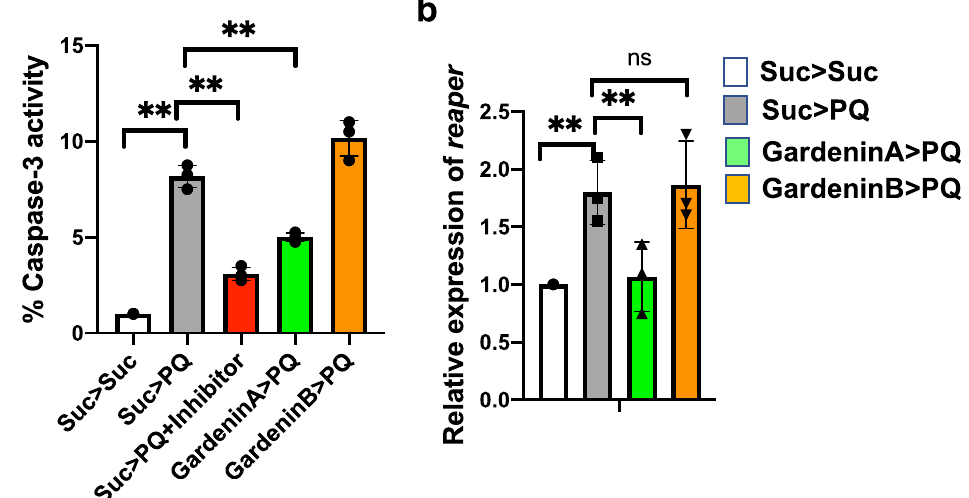
Fig. 5 Effects of GardeninA and GardeninB on the caspase dependent apoptotic responses in Drosophila . a Caspase-3 activity was measured in response to GA and GB using fl uorometric assay. Adult male fl ies were either pre-fed for 4 days with 2.5% sucrose or GA or GB (10 μ M) followed by exposure to either sucrose or 5 mM PQ or PQ + caspase-3 inhibitor (Ac-DEVD-CHO) for 24 h (white bar: Suc>Suc, gray bar: Suc>PQ, red bar: Suc>PQ + inhibitor, green bar: GardeninA>PQ, orange bar: GardeninB>PQ). The fl y head homogenates were used to detect the caspase-3 activities. Data are expressed as percentage in relation to the Suc>Suc control and represent averages from at least three independent biological repeats (mean ± SEM). ** p < 0.01 based on one-way ANOVA between different feeding conditions. b Effects of GA and GB on the transcript levels of reaper , the upstream proapoptotic gene in Drosophila using qRT-PCR. RNA was isolated from the heads of adult fl ies following exposure to the speci fi ed feeding conditions. The transcript levels of reaper were analyzed and plotted after normalization with rp49 levels as the internal control. Each data point represents mean ± SEM. The mRNA fold changes are normalized to the sucrose-fed (Suc > Suc) fl ies (assigned a value of 1). ** p < 0.01; ns: not signi fi cant between different feeding conditions based on Mann – Whitney U